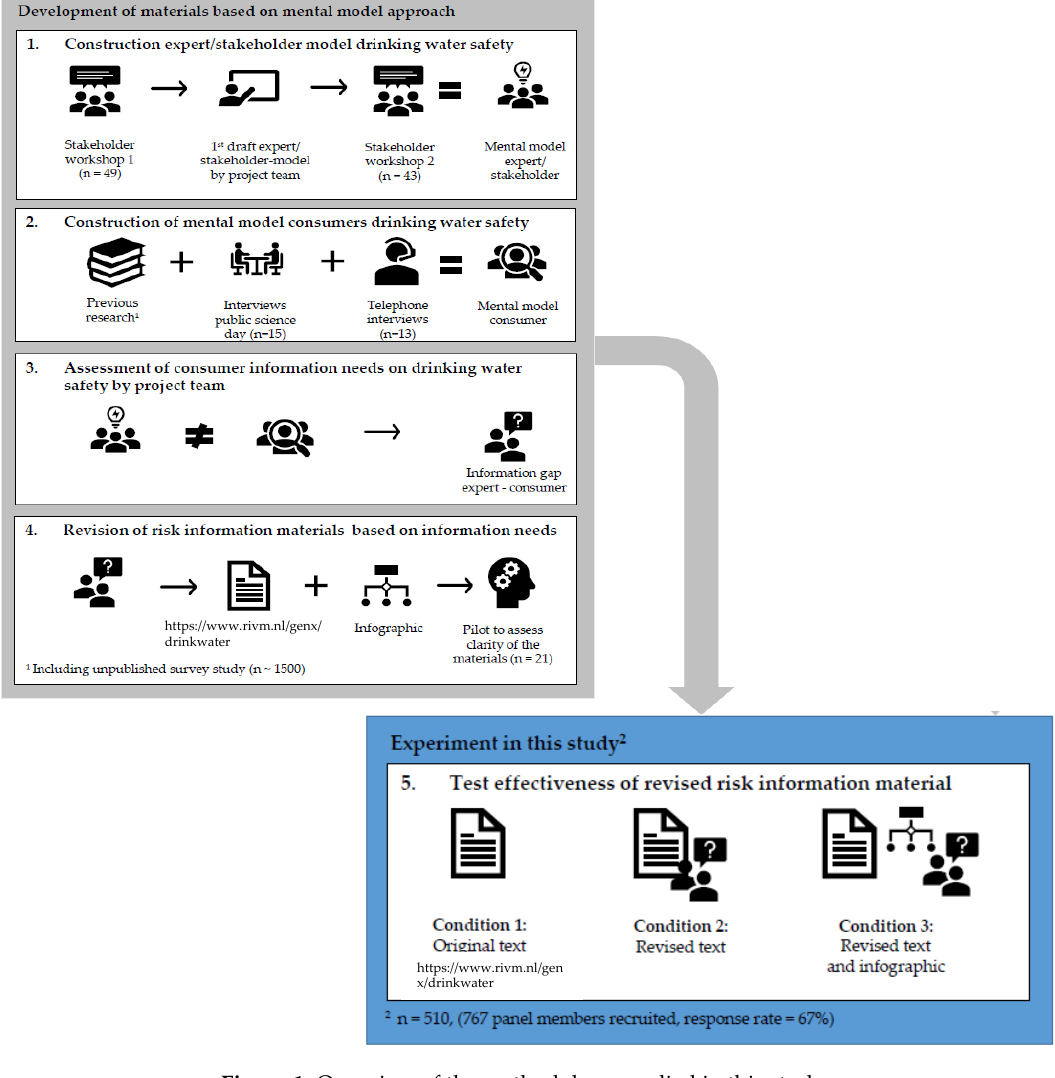
Figure 1. Overview of the methodology applied in this